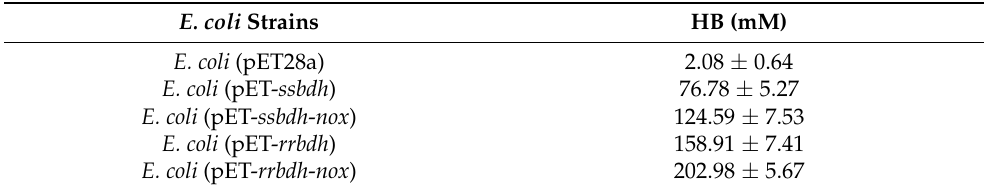
Table 3. The feasibility of HB production from 1,2-BD mixture by recombinant